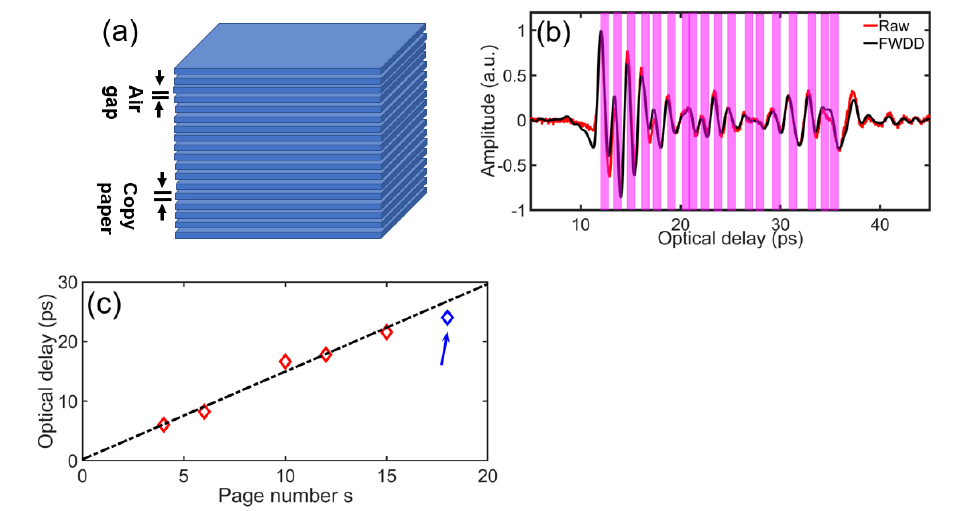
Figure 5. ( a ) Schematic of s = 18 stack. ( b ) Raw (red) reflected signal in THz TOFT experiment and the corresponding deconvolved signal after frequency wavelet-domain deconvolution (FWDD) (black). Pink vertical bars indicate the reconstructed locations of the paper sheets in the stack. ( c ) Relationship between optical delay from the linear fit based on the data for s = 4, 6, 10, 12, and 15 (red) and the measured optical delay (blue) for s =